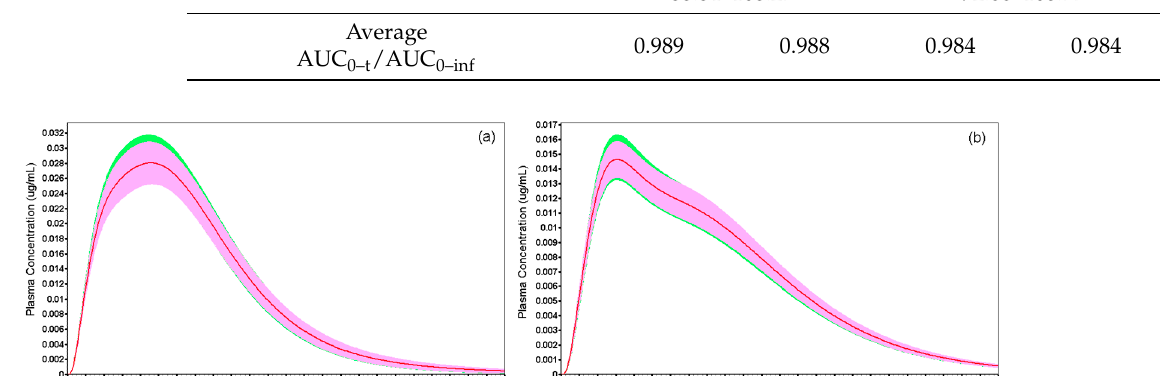
Figure 11. Virtual bioequivalence studies between the optimized formulation FO (green) and refer- ence drug product Selopress Zok ® (pink), both containing 95 mg of metoprolol succinate, in fasted state ( a ) and fed state ( b ).